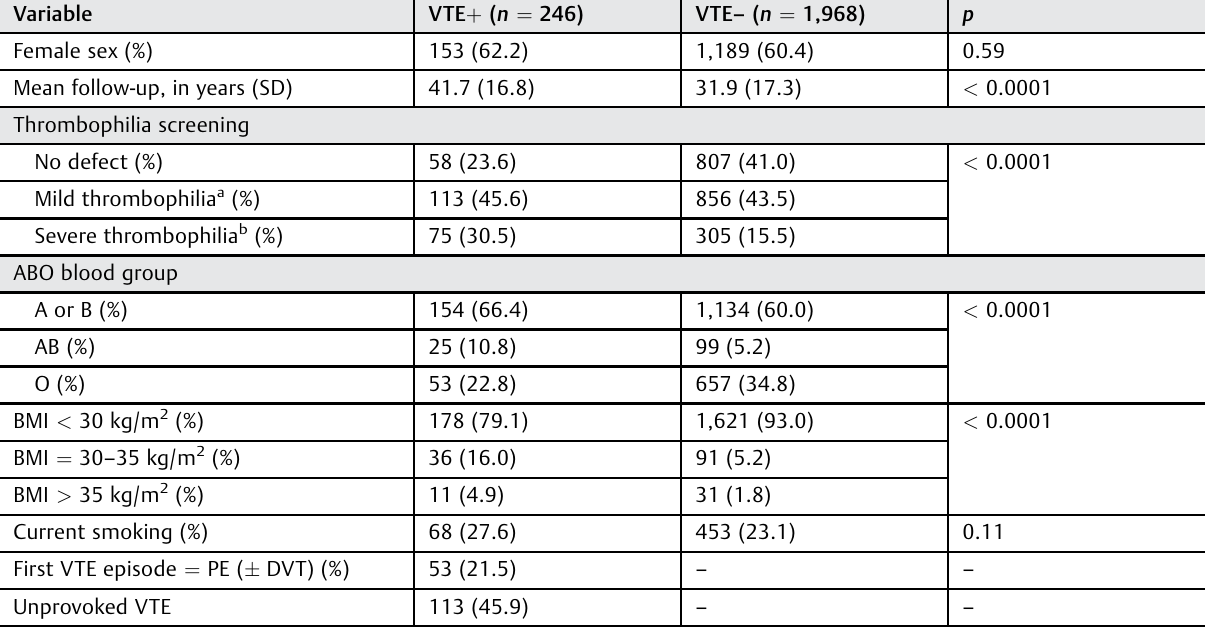
Table 1 Main characteristics of the relatives according to the VTE